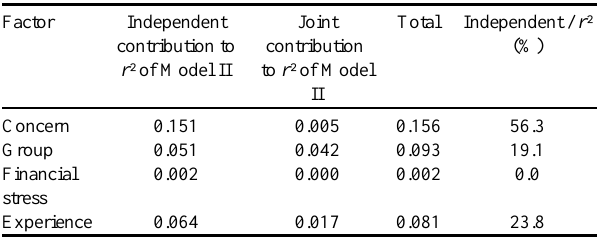
Table 5 . Hierarchical partitioning of the variables in Model II, showing the independent and joint contributions of each variable to the explained variance in total allowable commercial catch (TACC) estimates (r²).